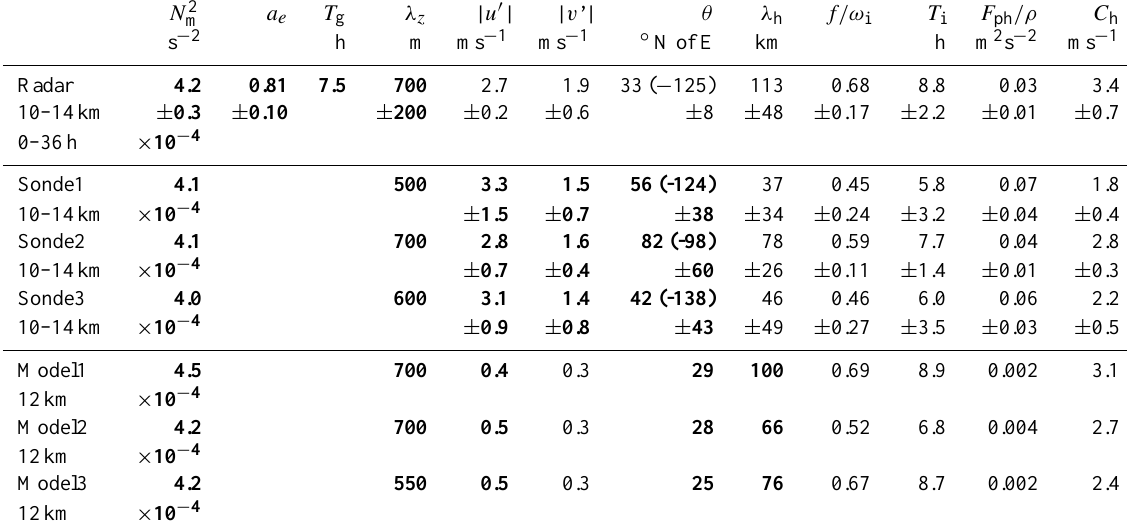
Table 1. Wave parameters from three different methods. Values in bold are directly estimated from the observed or modelled fluctuations, other parameters are calculated using wave dispersion and polarization relations as described in Sect. 5. N 2 m is mean squared buoyancy frequency, a e the relative amplitude of the wave in N 2 , T g the ground based wave period, λ z and λ h the vertical and horizontal wavelengths, | u 0 | and | v 0 | the amplitudes of the wind fluctuations parallel and perpendicular to the horizontal wave vector k , θ the direction of k , f the Coriolis parameter, ω i the intrinsic frequency, T i the intrinsic period of the wave, F ph / ρ the vertical flux of horizontal momentum parallel to k , C h the horizontal phase speed parallel to k . Sonde1/model1 are at 21:00UTC on 21 February, sonde2/model2 at 02:00UTC on 22 February, sonde3/model3 at 05:00UTC on 22 February. All model results for the vicinity of the radar. N 2 m